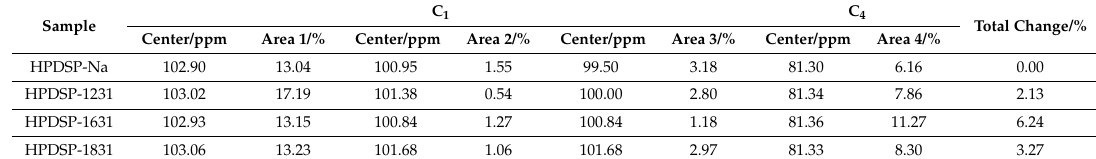
Table 3. Positions of the C 1 and C 4 peaks of the HPDSP nanocomposite films and their respective